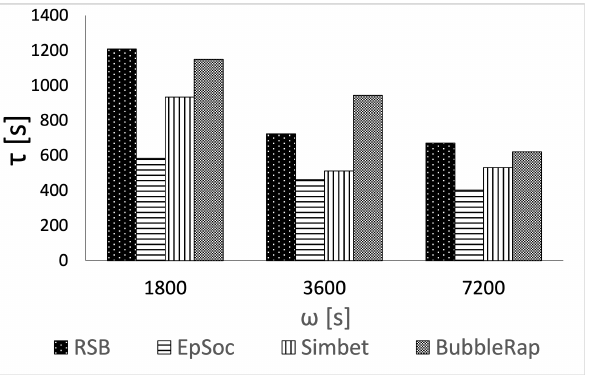
Figure 8. Latency average ( τ ) as a function of the message generation interval ( ω